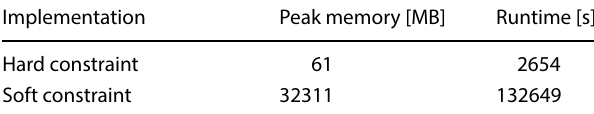
Table 2 The effect of hard versus soft